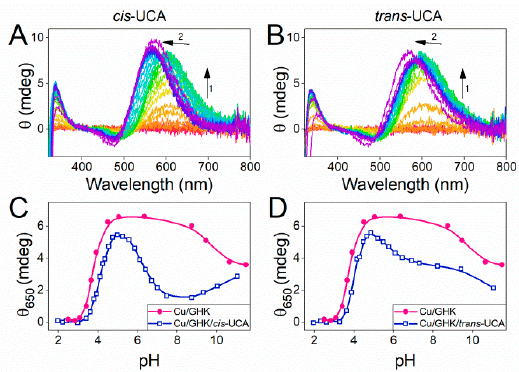
Figure 4. spectra of 0.95 mM GHK, 0.8 mM CuCl 2 , and 6 mM cis -UCA ( A ) or trans -UCA ( B ) in pH-metric manner. Arrows indicate the spectral changes from low to high pH. The ellipticity at 650 nm was read from panels (A) and (B) and shown for cis -UCA ( C ) or trans -UCA ( D ) (navy squares) juxtaposed to data obtained via pH-metric titration of 0.95 mM GHK with 0.8 mM CuCl 2 (magenta circles).